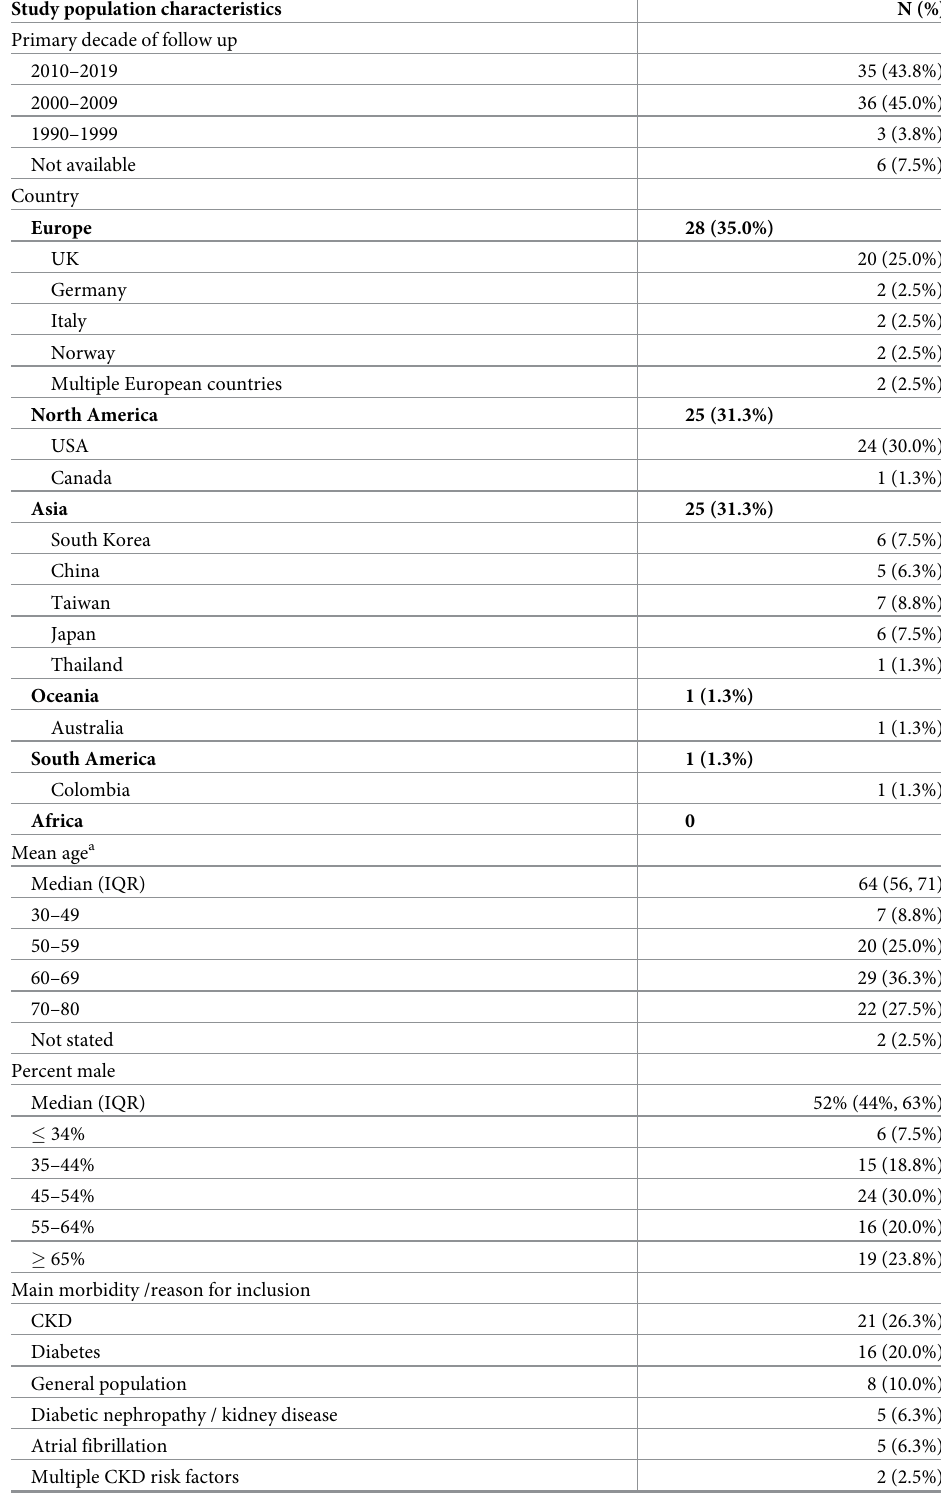
Table 1. Summary of study populations studied (N =